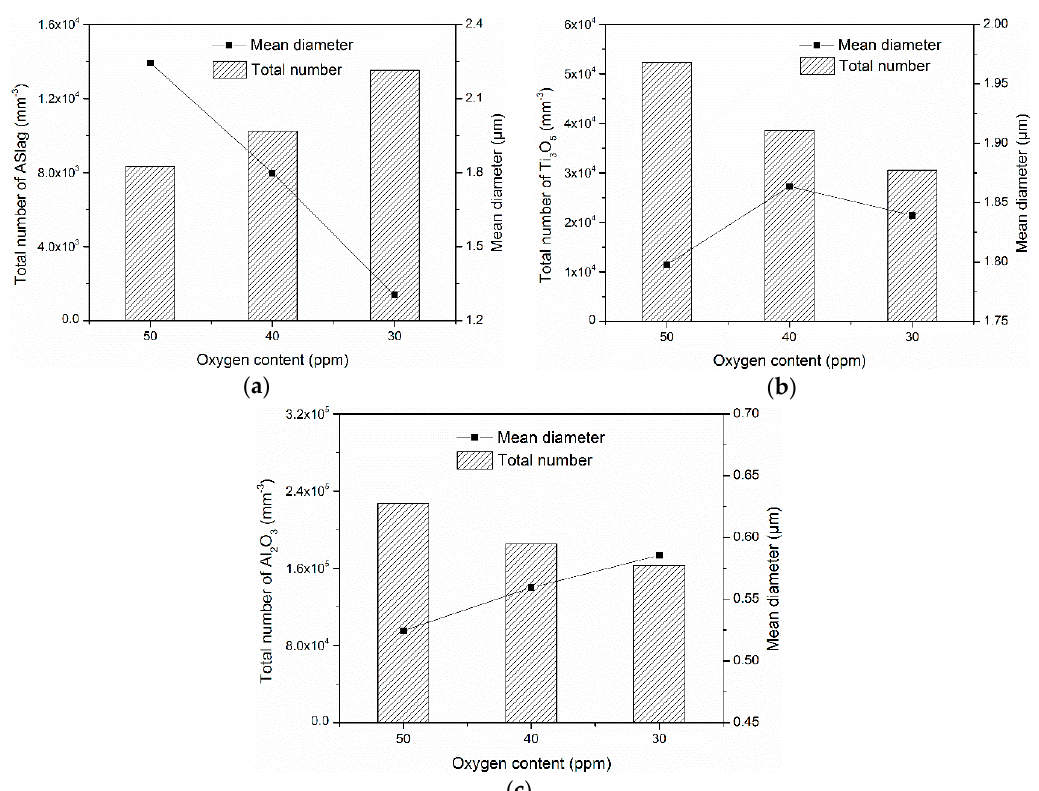
Figure 10. Influence of oxygen content on the number and mean diameter of ( a ) ASlag, ( b ) Ti 3 O 5 and ( c ) Al 2 O 3 .